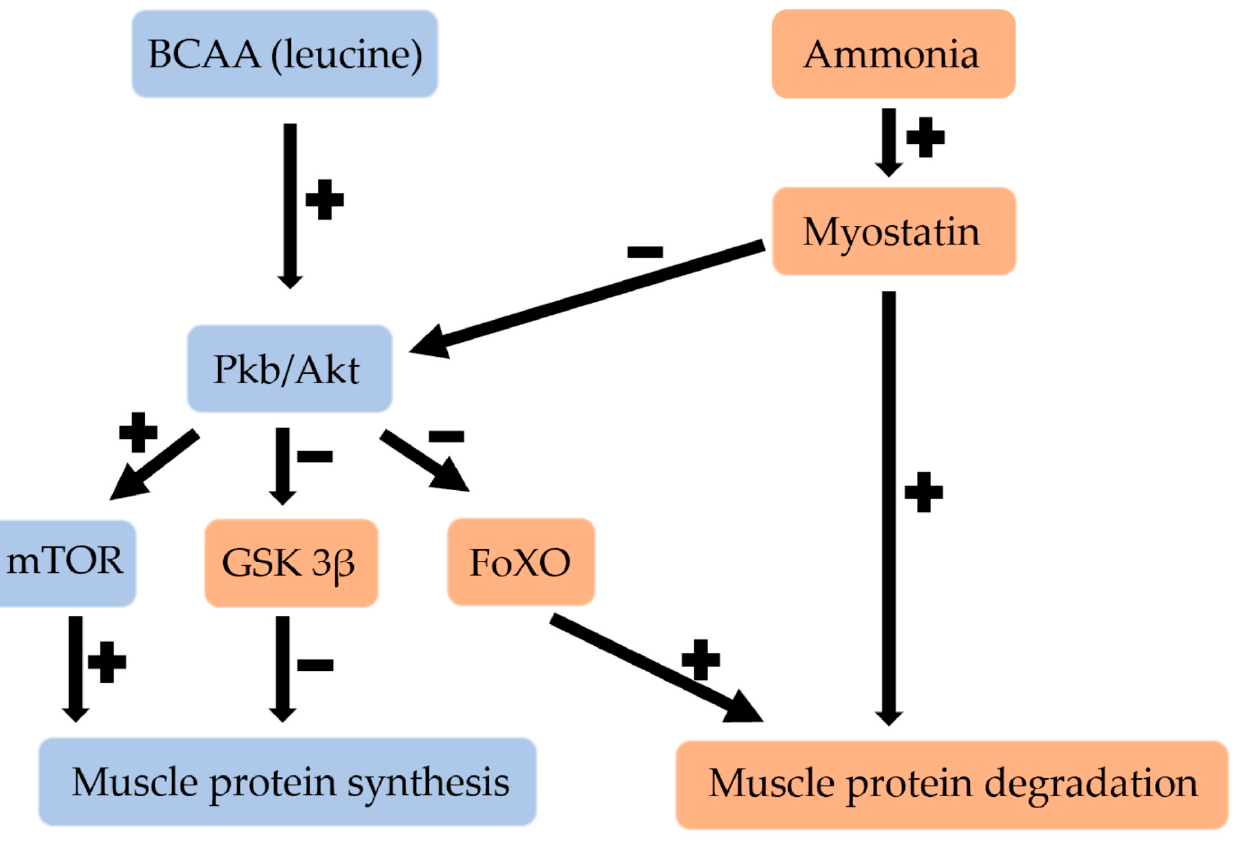
Figure 2. Regulation of skeletal muscle in liver cirrhosis. Blue: beneficial for skeletal muscle. Orange: harmful for skeletal muscle. BCAA: branched-chain amino acid, Pkb/Akt: protein kinase B, mTOR: mammalian target of rapamycin, GSK 3 β : glycogen synthase 3 beta, FoXO: forkhead box class O. Plus and minus signs indicate up-regulation and down-regulation respectively.